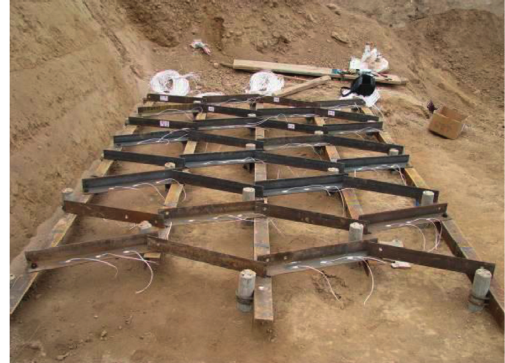
Figure 5: The connecting beam on the top of micropiles.